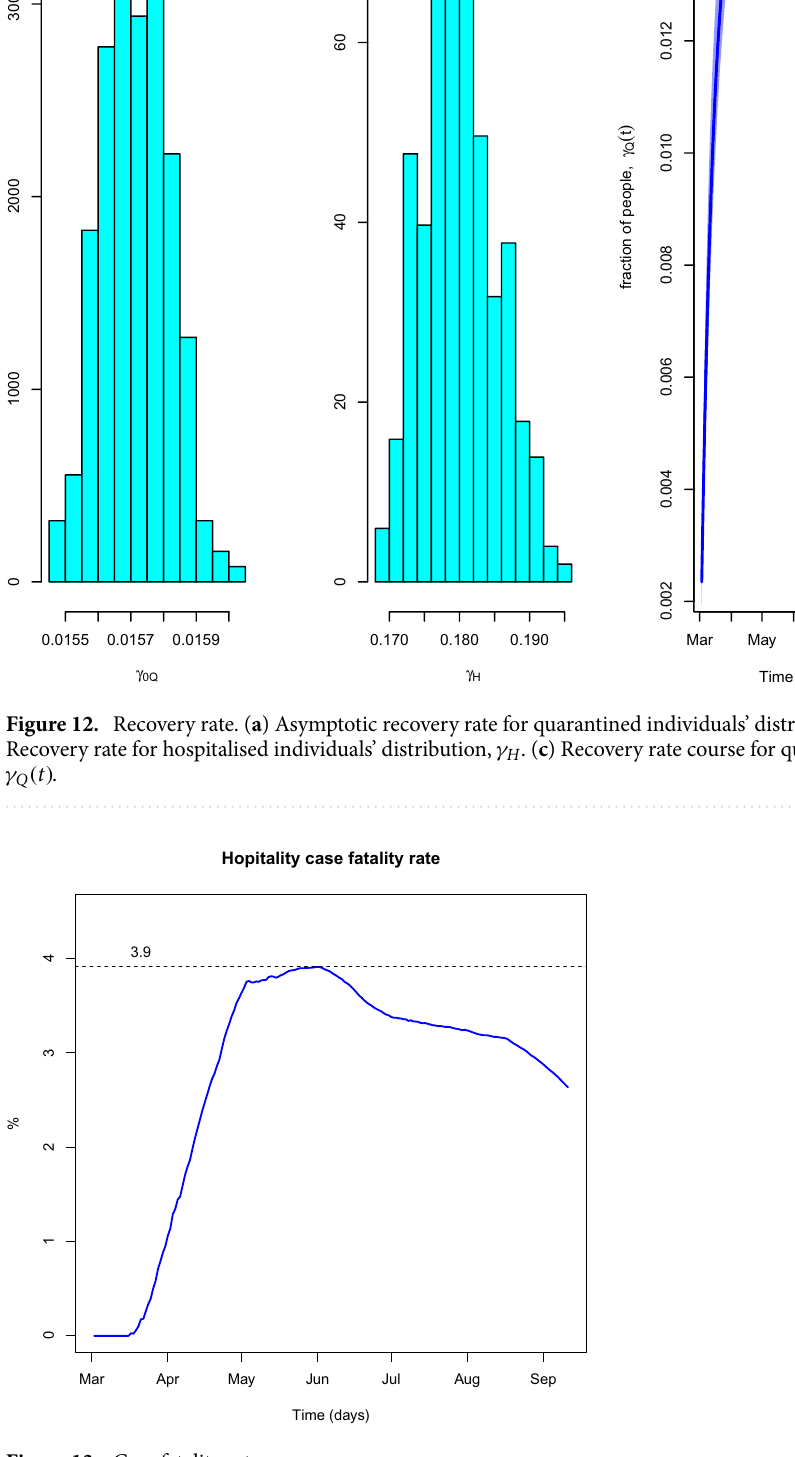
Figure 13. Case fatality